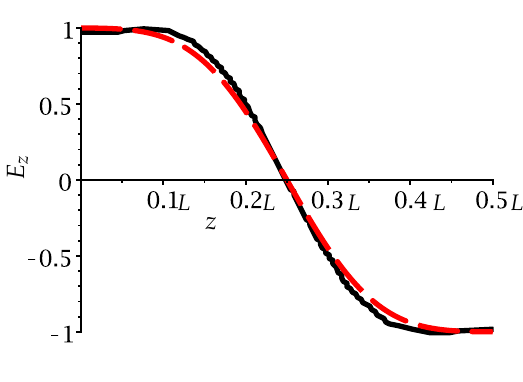
Figure 11. Field profile shaping in a metallic waveguide containing a 4 × 4 array of wires with varying radii in a metallic cavity, and with L = 80.61 mm. The simulated field profile E z itself is normalised and shown with solid black lines, and is compared with the ideal Mathieu function profile shown as a dashed red curve.